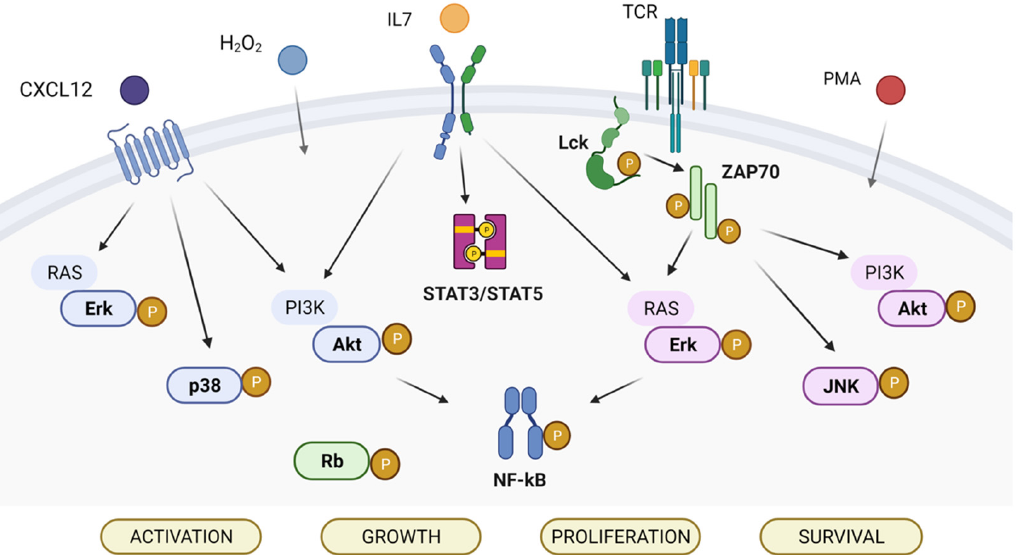
Figure 1. Signaling pathways analyzed in the study. The analyzed phosphoproteins are highlighted in bold.